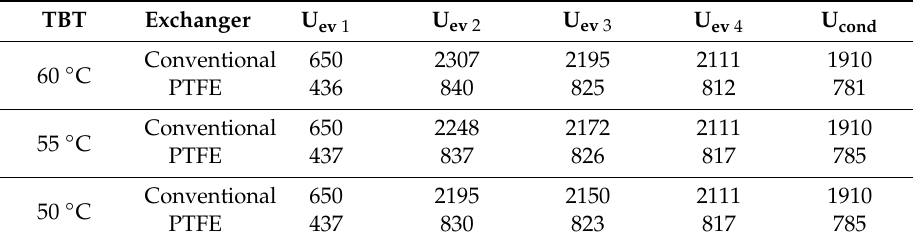
Table 2. Overall heat transfer coe ffi cients [W / (m 2 K)].